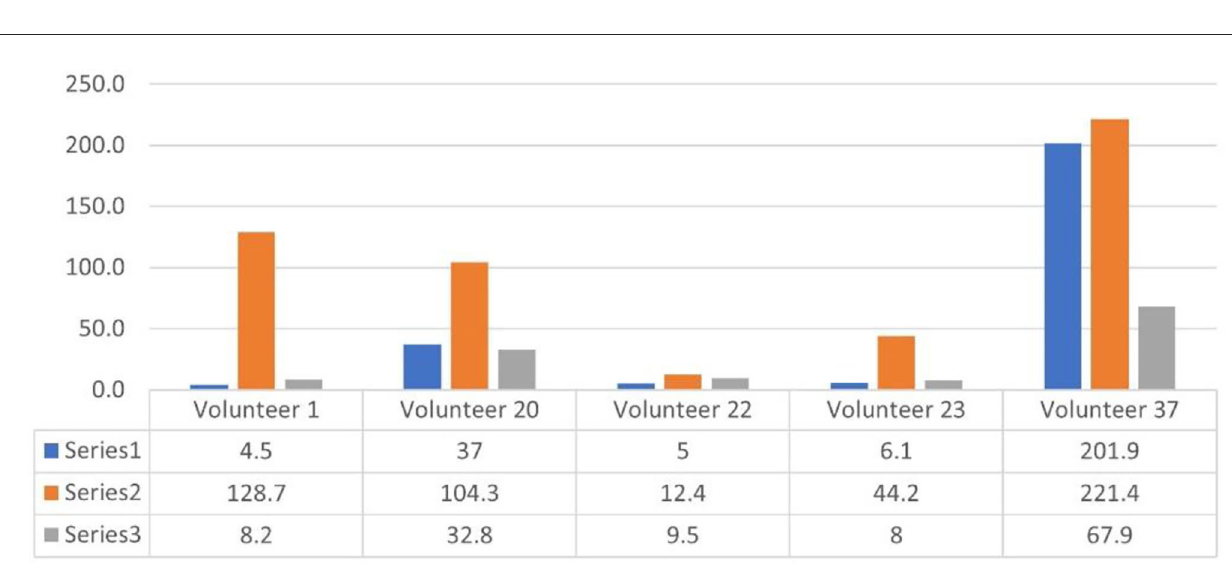
ability to provide reliable observations. Outcomes from MAE and MARE pointed out a decreasing margin of error in the performances of five consistently volunteers across the three observation stages.